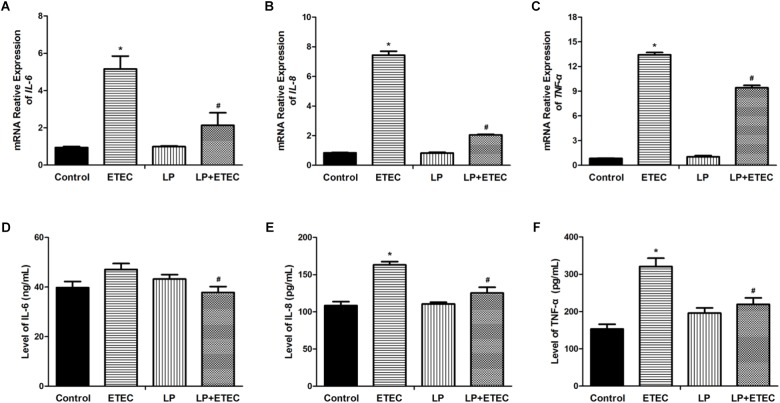
Relative mRNA transcript levels and concentrations of proinflammatory cytokines in the culture supernatant of IPEC-J2 cells left untreated or pretreated with L. plantarum ZLP001 (LP, 108 CFU mL−1) for 6 h then either unchallenged or challenged with 106 CFU mL−1 ETEC for 3 h. mRNA levels of IL-6
(A), IL-8
(B), and TNF-α
(C) were standardized to that of GAPDH. Expression levels relative to non-treated controls were calculated by the 2−ΔΔCT method. Protein expression of IL-6 (D), IL-8 (E), and TNF-α (F) was assessed by ELISA. Values are shown as the means ± SE of three independent experiments. ∗P < 0.05 vs. non-treated controls; #P < 0.05 vs. ETEC alone.